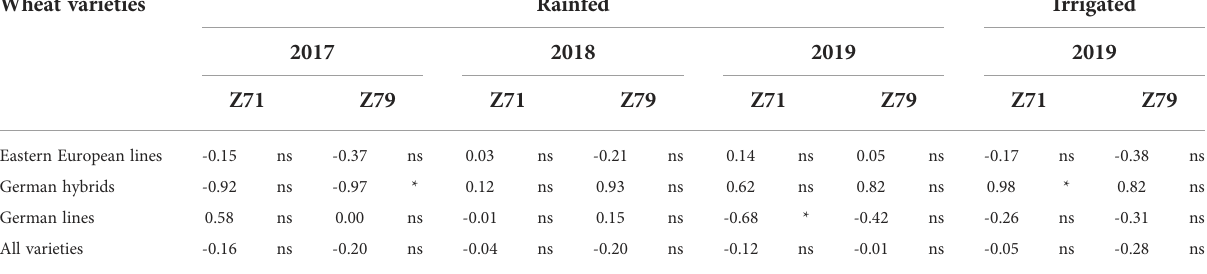
TABLE 4 Correlation between relative leaf water content (RLWC) measured at Z71 and Z79 and wheat grain yield (Eastern European lines, German hybrids, German lines, and all varieties) under rainfed and irrigated fi eld conditions in Moldova in 2017, 2018 and 2019. Wheat varieties Rainfed Irrigated